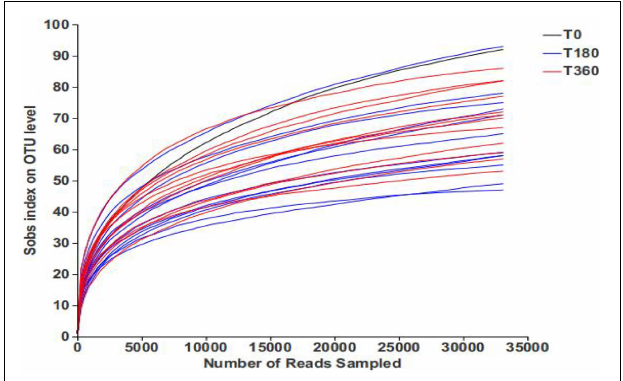
FIGURE 1 | Rarefaction curves of barley samples under different storage conditions. Each curve represents a sequencing sample.